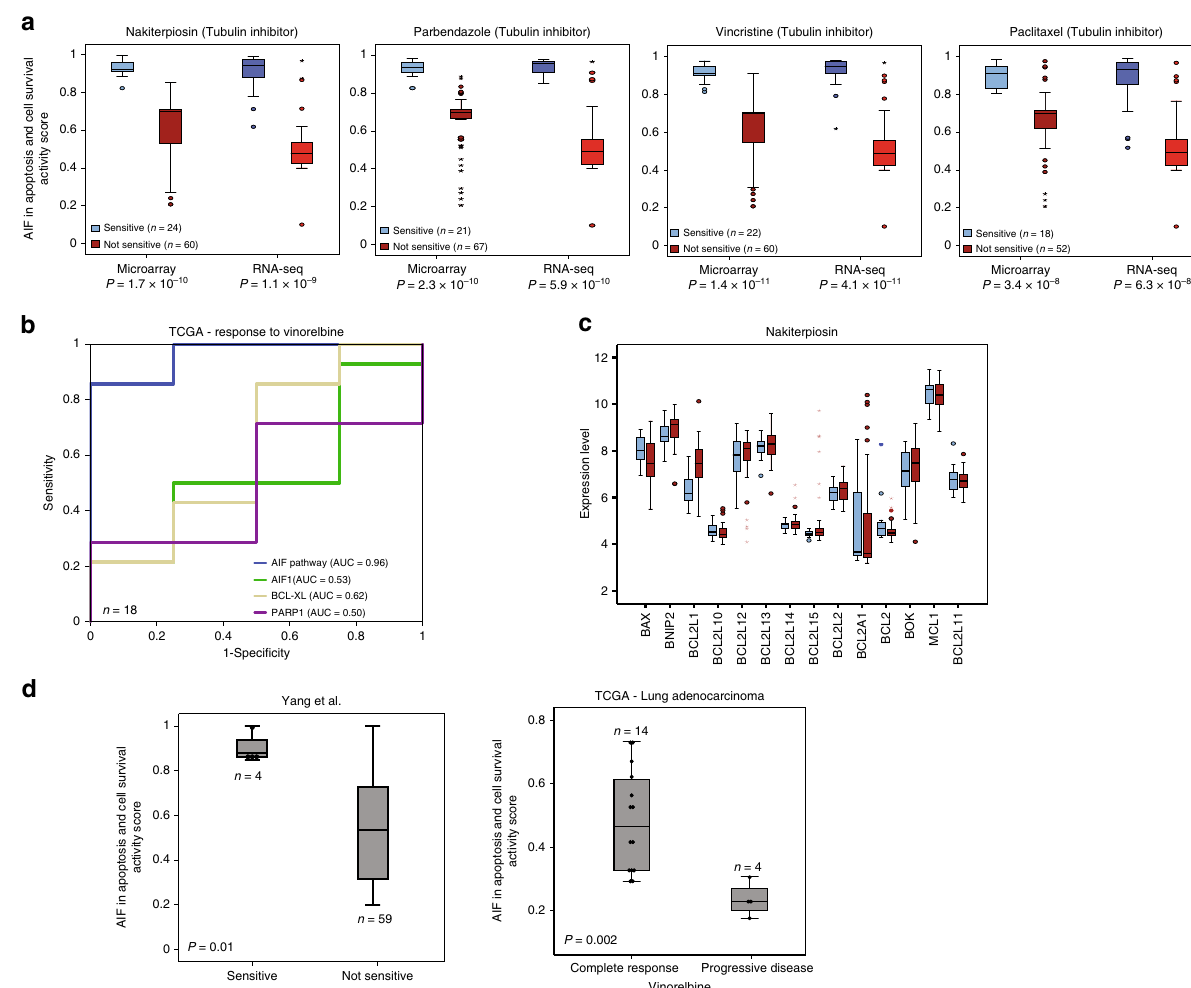
Fig. 3 AIF in apoptosis and cell-survival pathway predicts response to MTI. a ‘ AIF in apoptosis and cell-survival pathway ’ activity levels in sensitive (blue) and not-sensitive (red) lung cancer cell lines in microarray and RNA-seq. Box plots represent the MTIs that were identi fi ed by this analysis across all lung cancer cell lines. Error bars represent the standard deviation. P -values were generated using Mann – Whitney U -test. b ROC analysis was constructed to evaluate the prognostic power of the AIF pathway versus the three pathway genes ( AIF1 , BCL-XL , PARP1 ) in the TCGA lung adenocarcinoma dataset. The AUC was used to quantify response prediction. c Box plot of BCL2-protein family member expression levels in sensitive (blue boxes) and not-sensitive (red boxes) cell lines. Error bars represent the standard deviation. d Validation sets of lung cancer cell lines 25 and patients (TCGA) that were treated with MTIs. Box plots show AIF pathway activity levels in the sensitive and not-sensitive cell lines (left panel) as well as in patients with complete response or progressive disease (right panel). Error bars represent the standard deviation. P -values were generated using Mann – Whitney U -test. See also Supplementary Figs. 5,